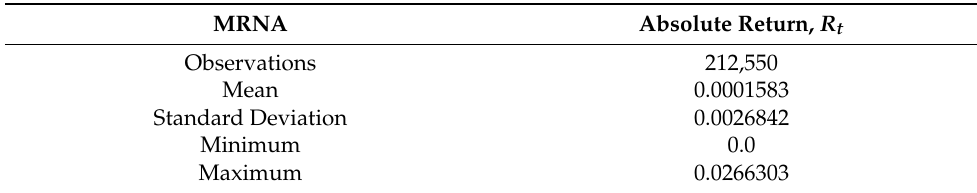
Table 3. Moderna Stock Return Descriptive